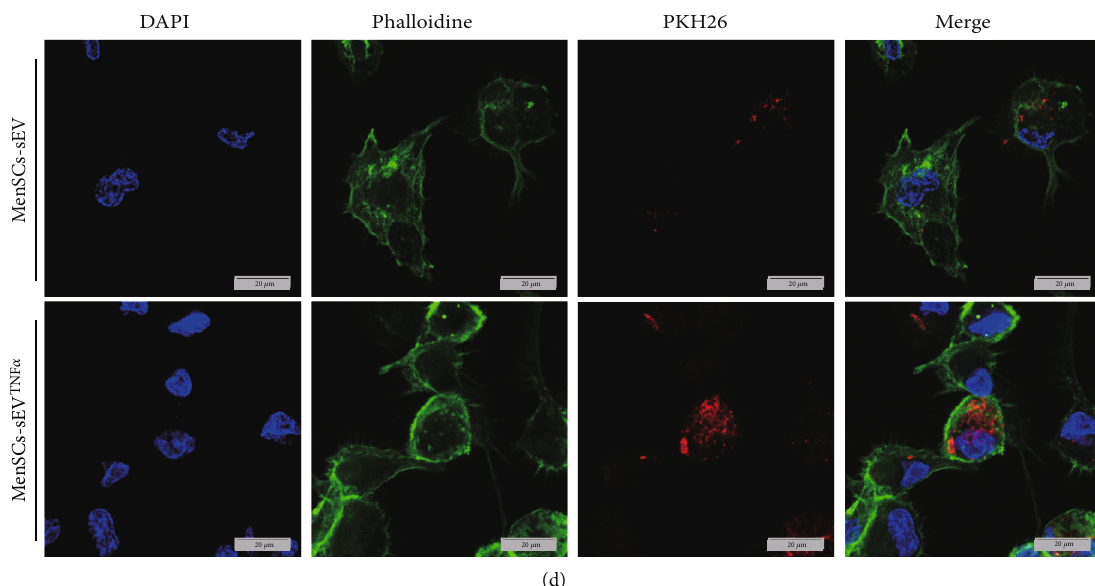
Figure 5: MenSCs-sEV TNF- α converts M1 macrophages into M2 macrophages in vitro. (a) Raw264.7 cells were treated with 100 ng/ml LPS and 100ng/ml IL-4 or 100 μ g/ml small EVs to measure the ratio of M2 by fl ow cytometry. IL-4 was used as a positive control. (b) The level of macrophage polarization was measured in murine bone marrow-derived macrophage (BMM) treated with MenSCs-sEV (100 μ g/ml) or MenSCs-sEV TNF- α (100 μ g/ml) by fl ow cytometry. (c) The expression of TNF- α , IL-1 β , IL-17, IFN- γ , iNOS, and Arg1 of RAW264.7 after di ff erent treatments were detected by PCR. (d) PKH26-labeled MenSCs-sEV and MenSCs-sEV TNF- α were absorbed by RAW264.7 cells, which were stained with FITC-phalloidine and DAPI and observed with confocal